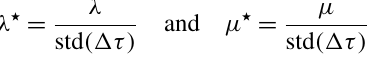
(between − 0 . 1 and 0.1), repeated for equally many